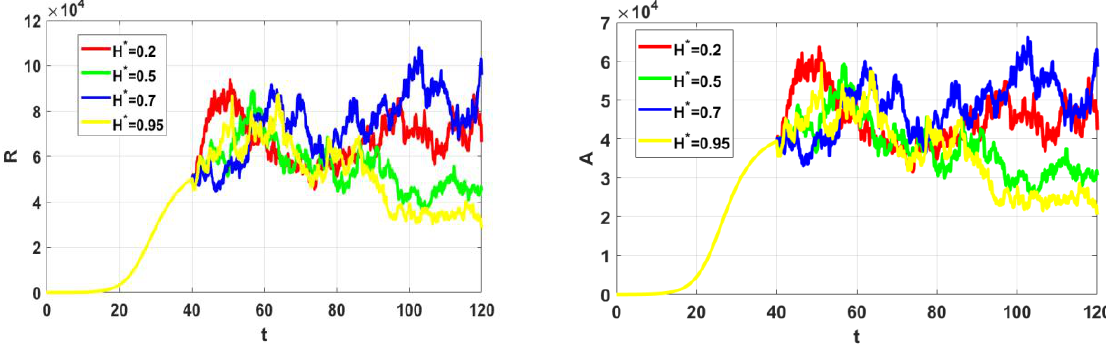
Figure 9. Numerical simulation for system (14–16) at α = 0.90, α 1 = 0.87 and different H ∗ , σ 1 = σ 2 = σ 3 = 0.01, σ 4 = σ 5 = σ 6 = σ 7 = σ 8 =